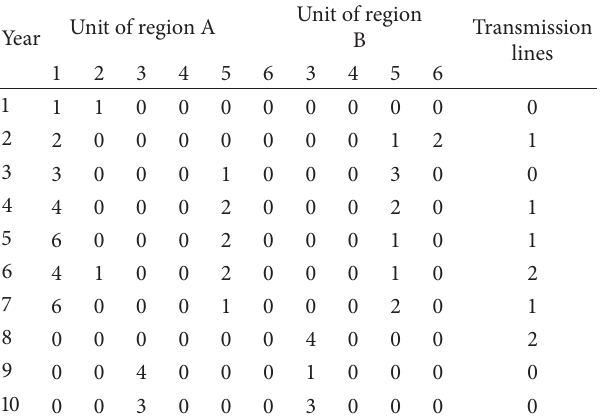
Table 10: Interregional power system planning results with